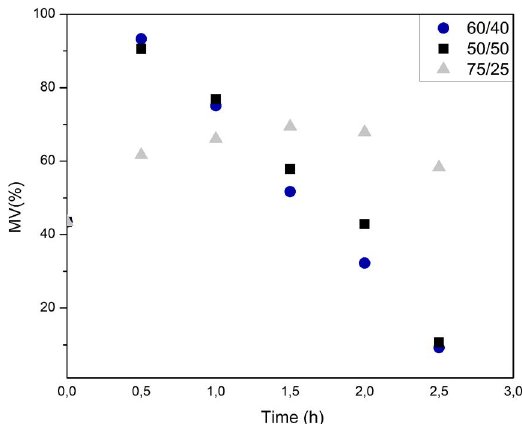
Figure 1. Mass Variation Data in Acidic medium.